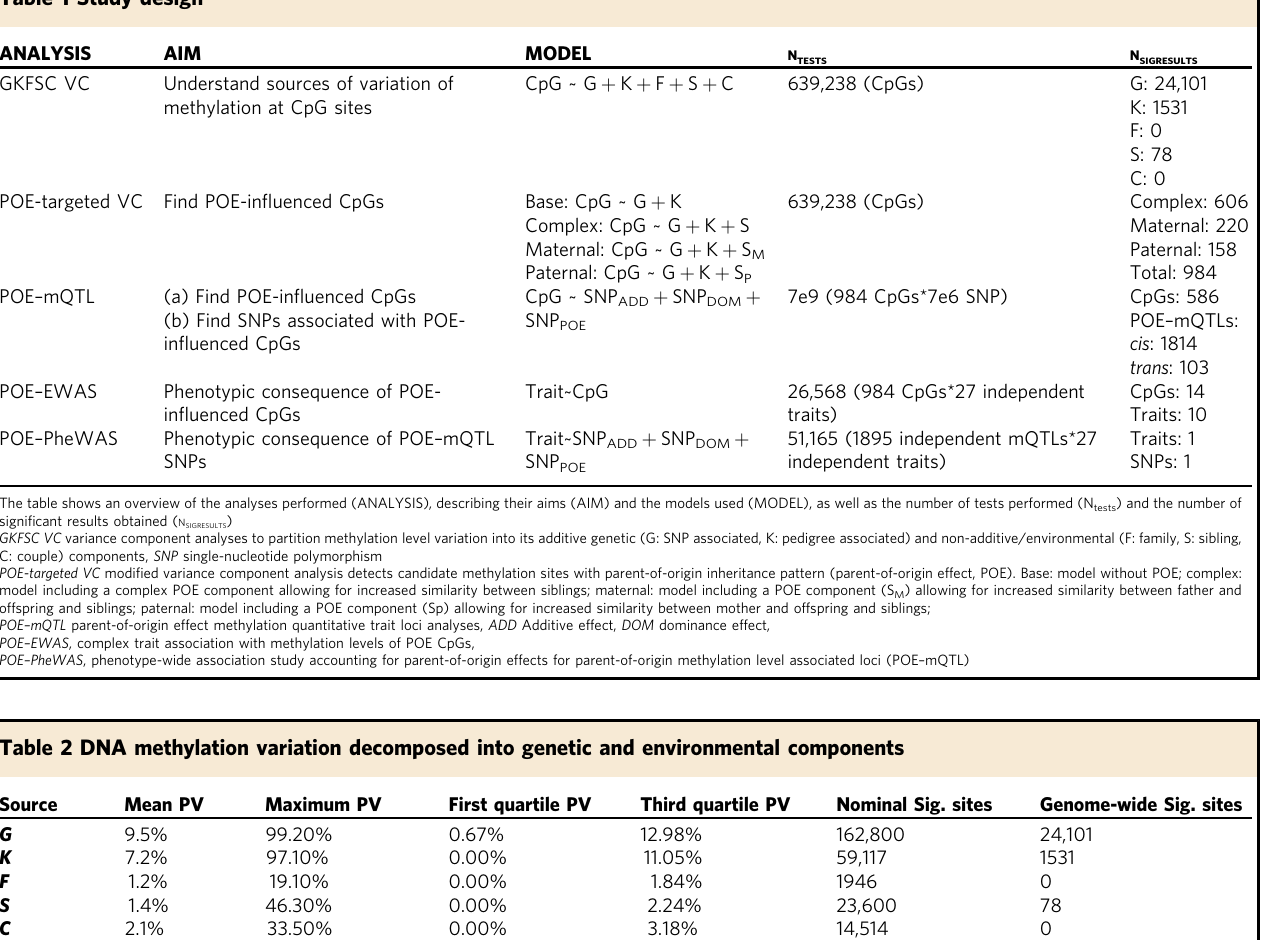
Proportion of variation in methylation levels at the 639,238 studied CpG sites explained (PV) by G (common SNP-associated additive genetic component), K (pedigree-associated additive genetic component), F (shared environmental effects between nuclear family members), S (non-additive genetic or shared environmental effects between full siblings) and C (shared environmental effects